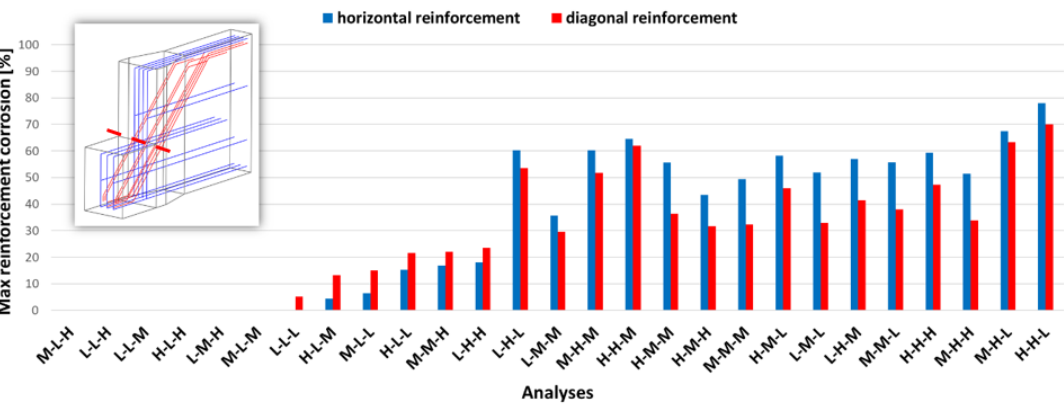
Figure 17. Reinforcement corrosion as a function of chloride parameter combination for case t95.